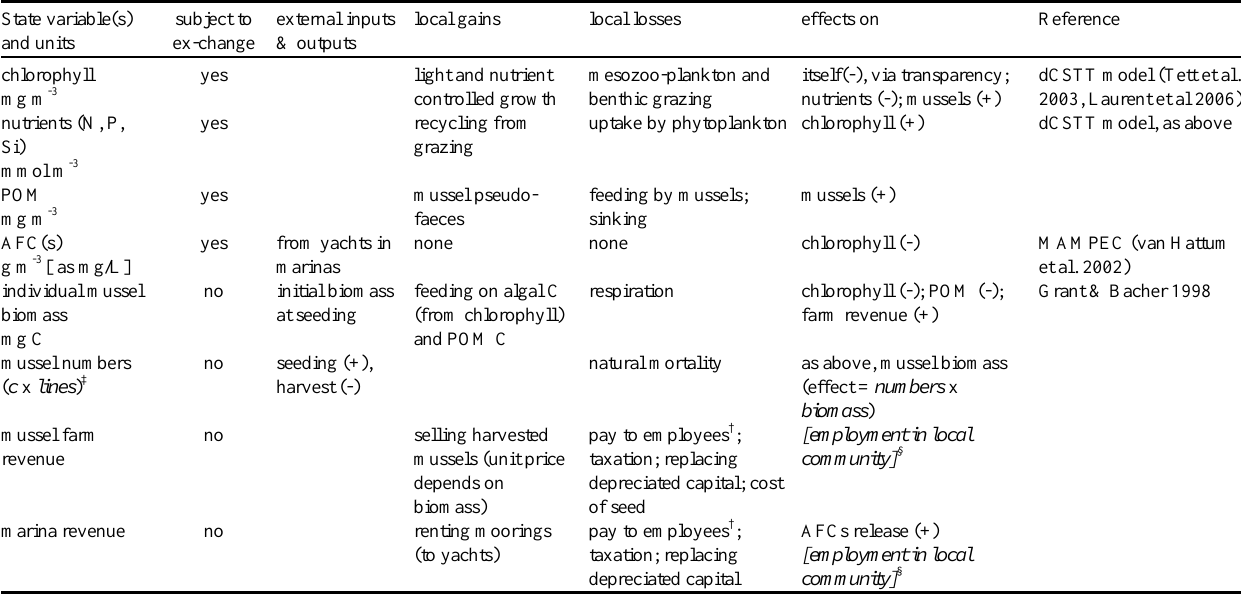
Table 3 . Model state variables and main terms (see also Fig. 4) State variable(s) and